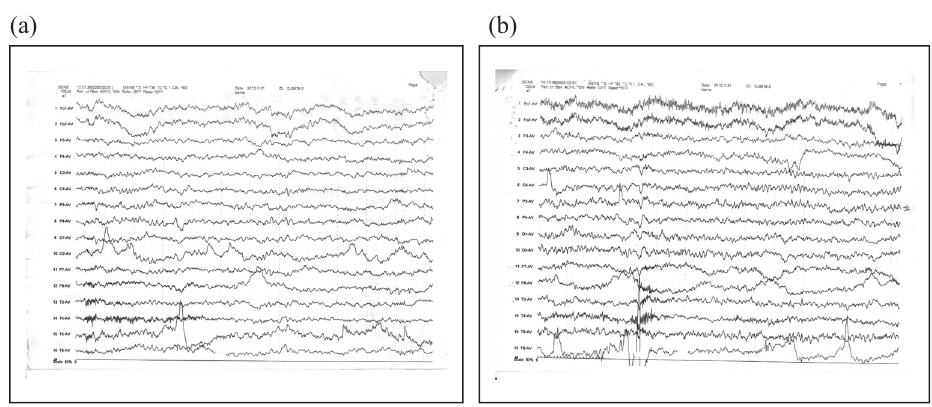
Figure 2. Representative EEG segments of the child 3 days after the procedure. A, Awake with closed eyes. B, Awake and moving.